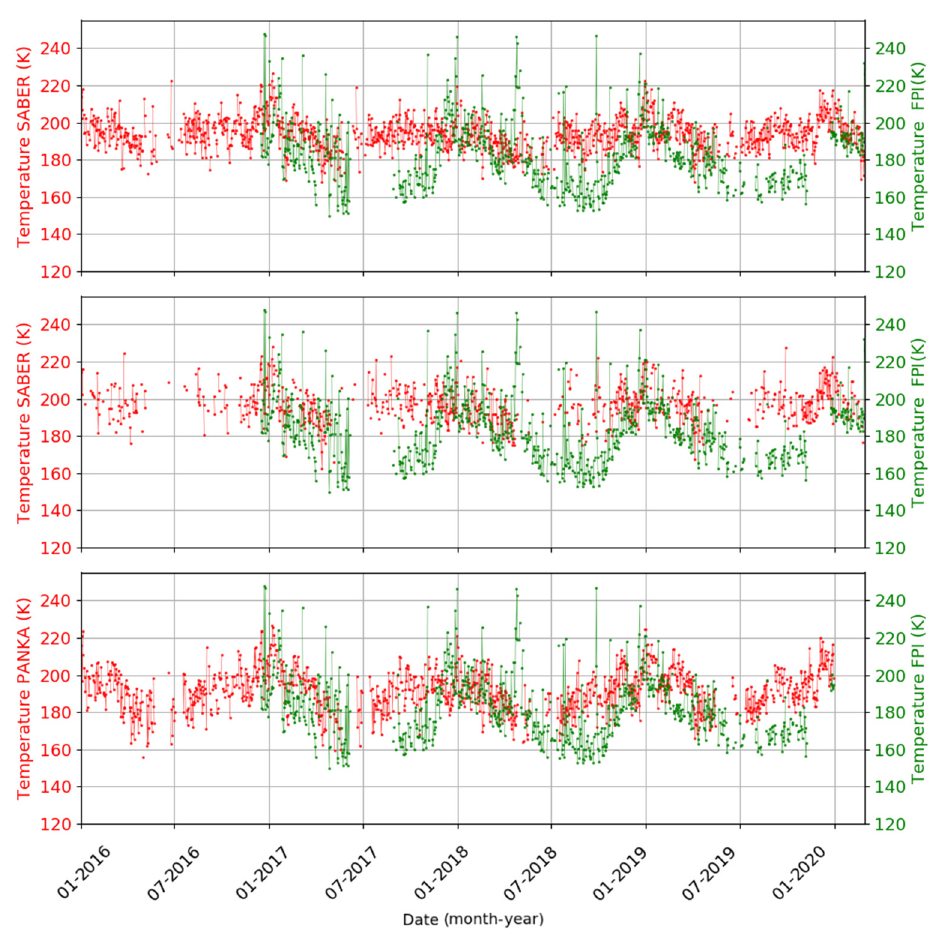
Figure 9. Dynamics of the temperature observed with Fabry–Pérot interferometer (green) and of the effective temperature calculated from SABER data (red) in 2016–2020 above GPO in Tory, nighttime. The top panel presents data calculated using [17], the middle panel presents data calculated using [24], and the bottom panel presents data calculated using [25].